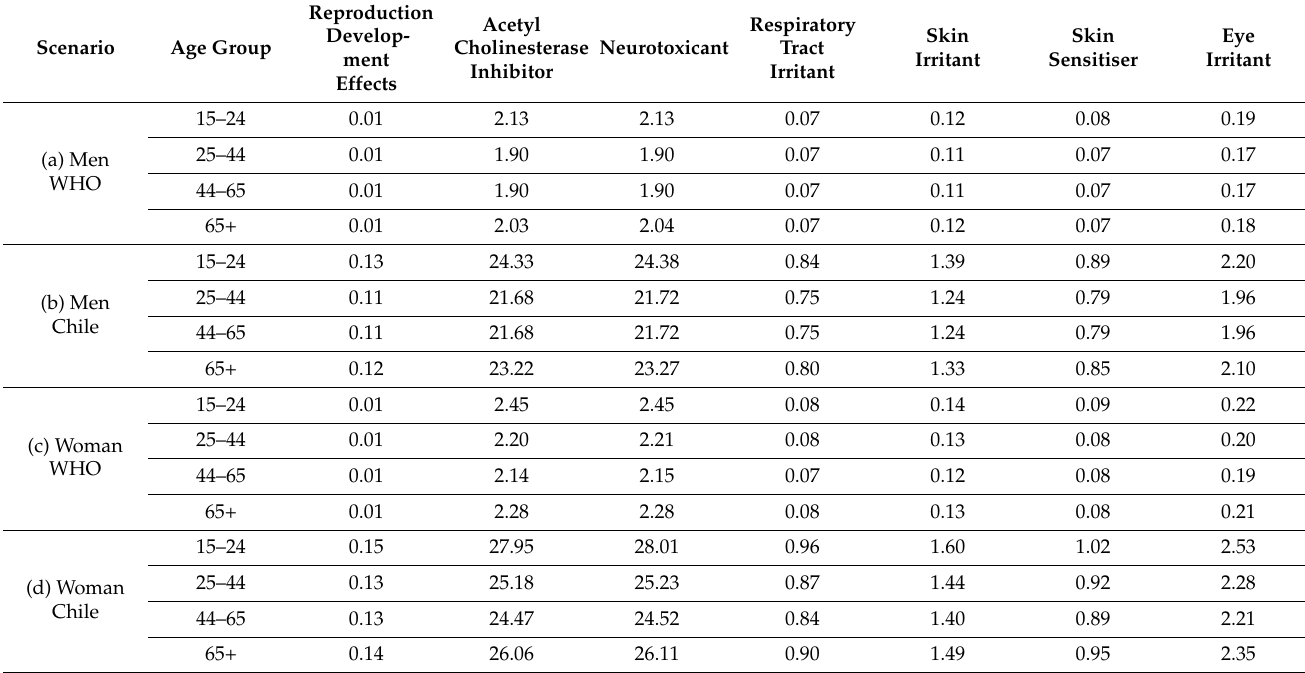
Table 3. Chronic Hazard Index for the for all the scenarios in fresh tomatoes from local supermarkets of Metropolitan region, Chile: (a) Men-WHO; (b) Men-Chile; (c) Woman-WHO; (d)